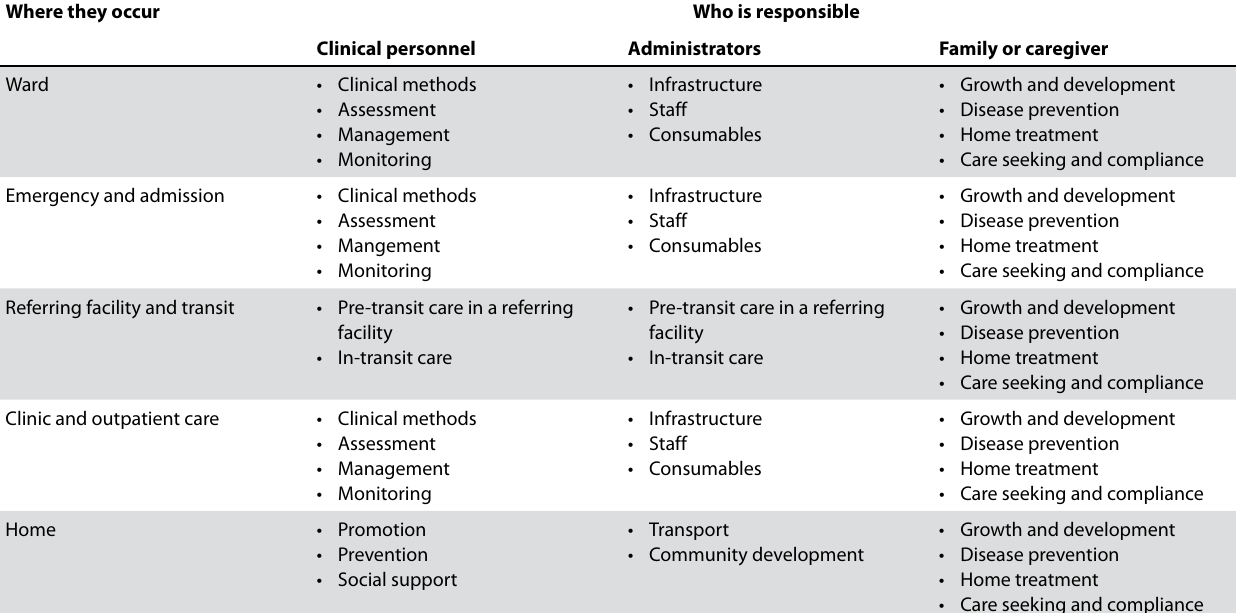
Table 1: Categorising modifiable factors when auditing a death using the Child Healthcare Problem Identification Programme Where they